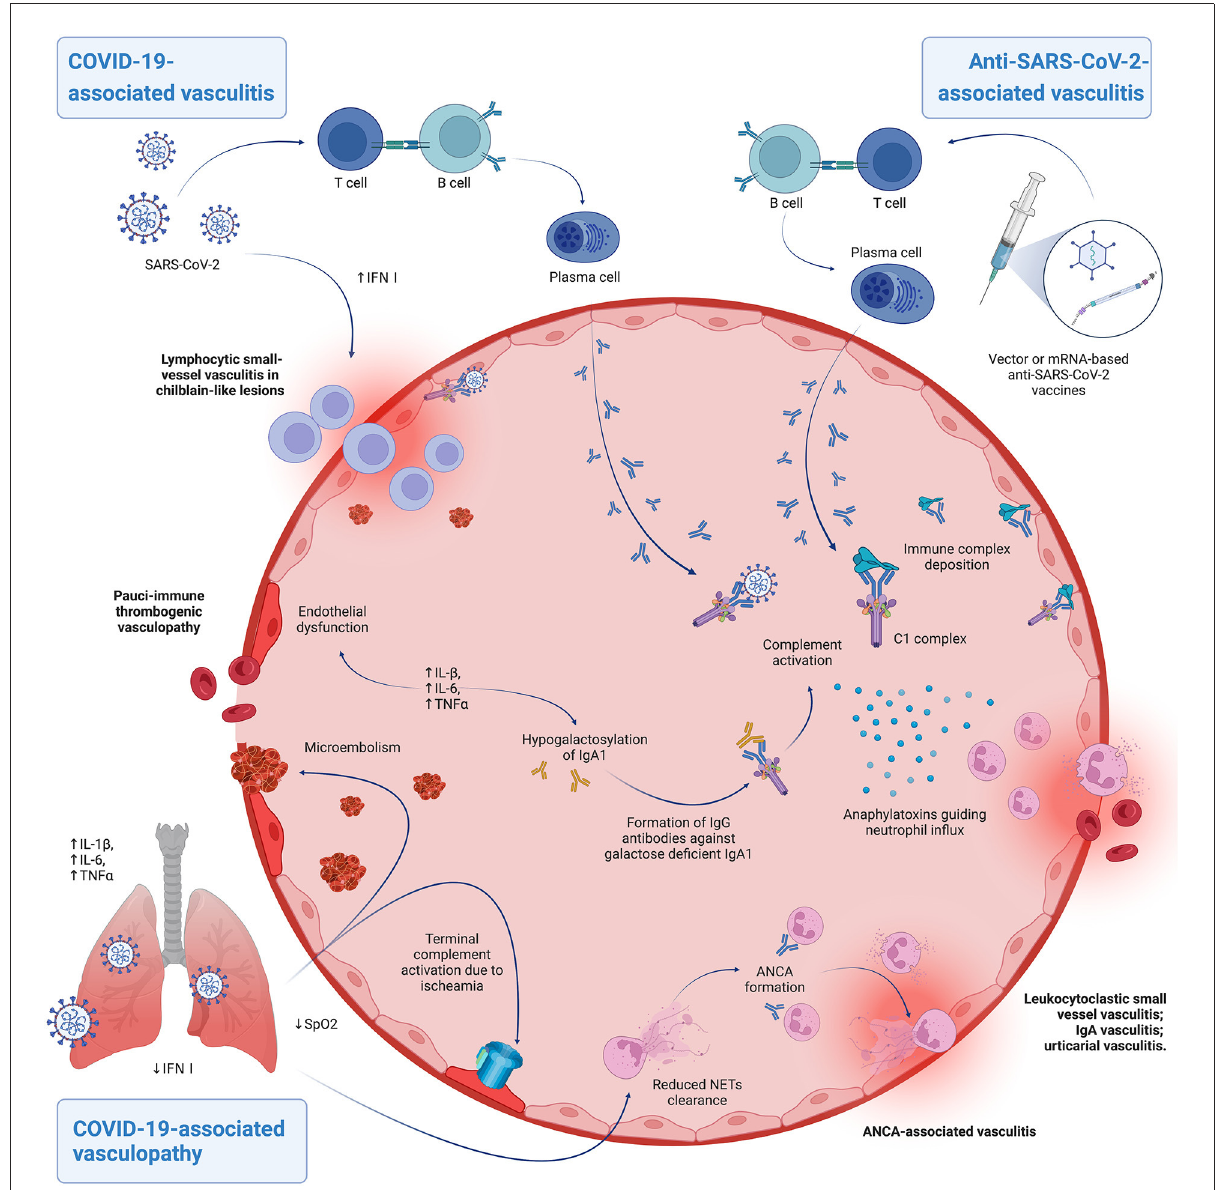
FIGURE1 Hypothesized pathomechanisms of COVID-19-associated vasculitis/vasculopathy and anti-SARS-CoV-2-vaccine associated vasculitis. Patients able to mount a robust type I interferon response can develop lymphocytic perivascular cuffing during infection, leading to chilblain-like